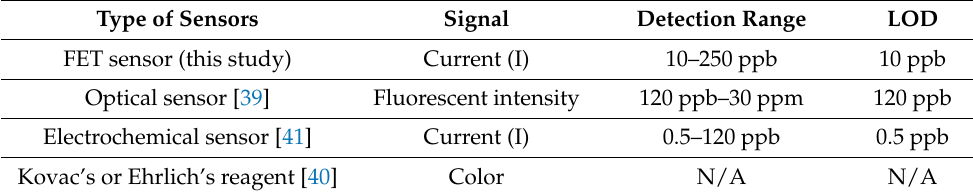
Table 1. The performance of various reported indole sensing